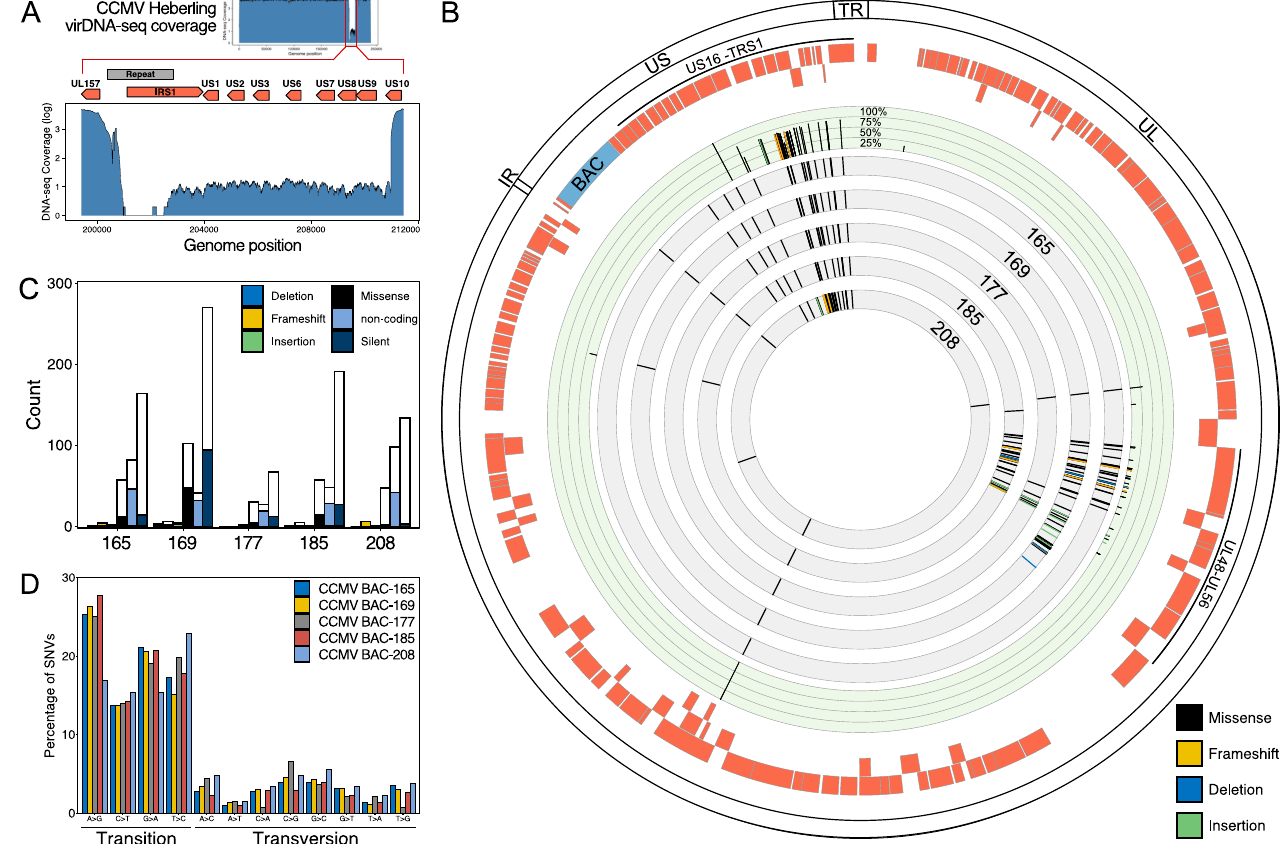
Fig 2. Genotypic analysis of CCMV clones. (A) Drop in sequencing read coverage indicates that a large proportion of viral genomes within the parental CCMV Heberling pool have a deletion event between IRS1 and US10. (B) Whole genome sequencing revealed variations in genomic sequences of selected CCMV BAC clones and the parental CCMV Heberling. Positions of missense, frameshift, deletion and insertion mutations for BAC clones are plotted in the grey tracks of the Circos plot. Intra-strain variations of the CCMV Heberling isolate are plotted in the green track; the frequency of each variation is indicated. Outer tracks: CCMV ORFs (red) and genomic regions. (C) The individual BAC clones were compared with the CCMV Heberling reference sequence for the absolute counts of single nucleotide variations (SNVs). White stacked bars indicate number of variations detected based on the alignment to the reference genome sequence of Heberling (NC_003521.1) but found in the re-sequenced parental CCMV virus stock pool. Colored bars indicate de novo variations in each clone that are neither detected in the original reference sequence nor the parental CCMV virus stock. CCMV BAC-177 showed the lowest number of SNVs and contained no frameshift mutations. (D) Similarly, the BAC clones were analyzed for the spectrum of transition and transversion mutations.